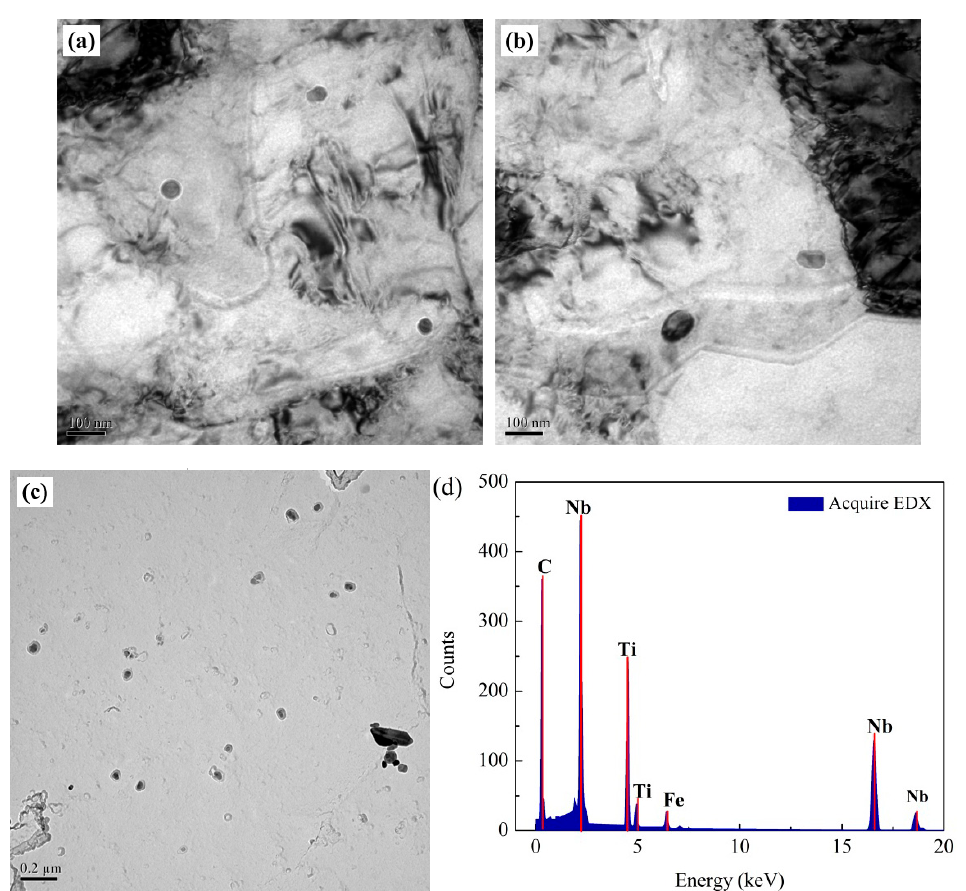
Figure 7. Precipitation morphology of 22 mm X80 pipeline strip processed by ultrafast cooling (UFC). ( a )–( c ) are morphology of precipitates. ( d ) is energy spectrum of precipitate.